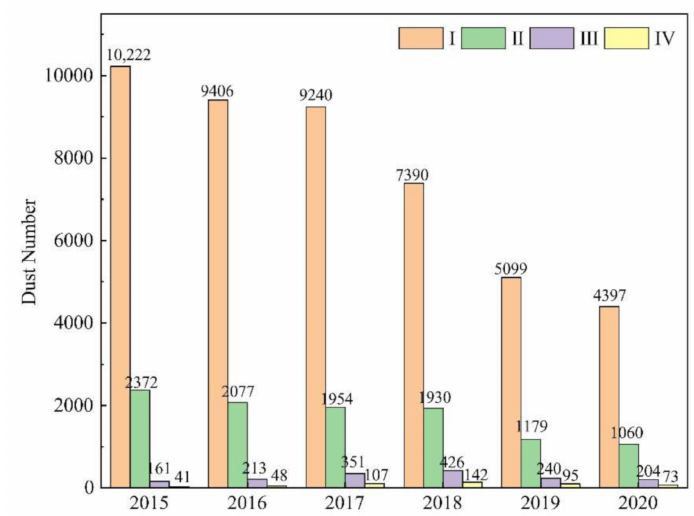
Figure 3. Annual change of the dust event frequencies for different levels from 2015 to